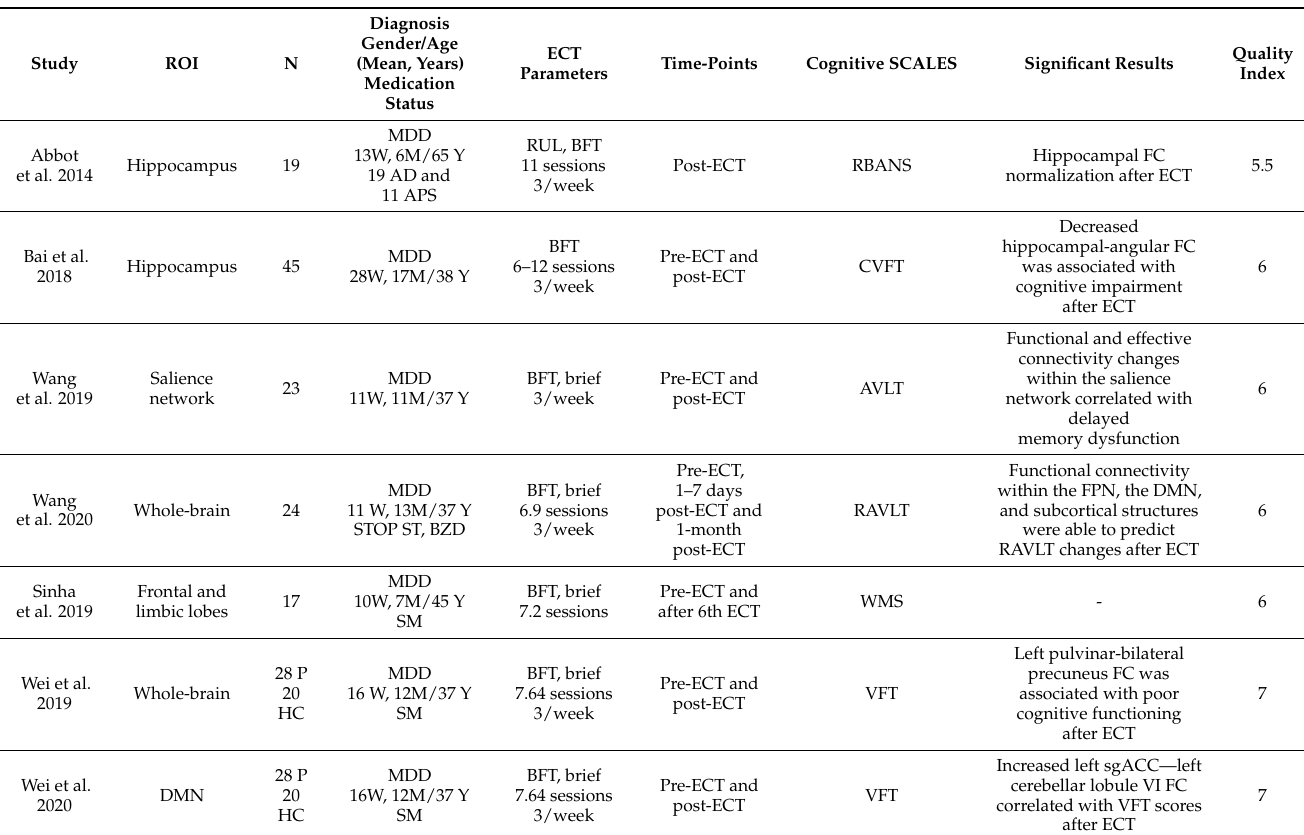
Table 3. Functional magnetic resonance